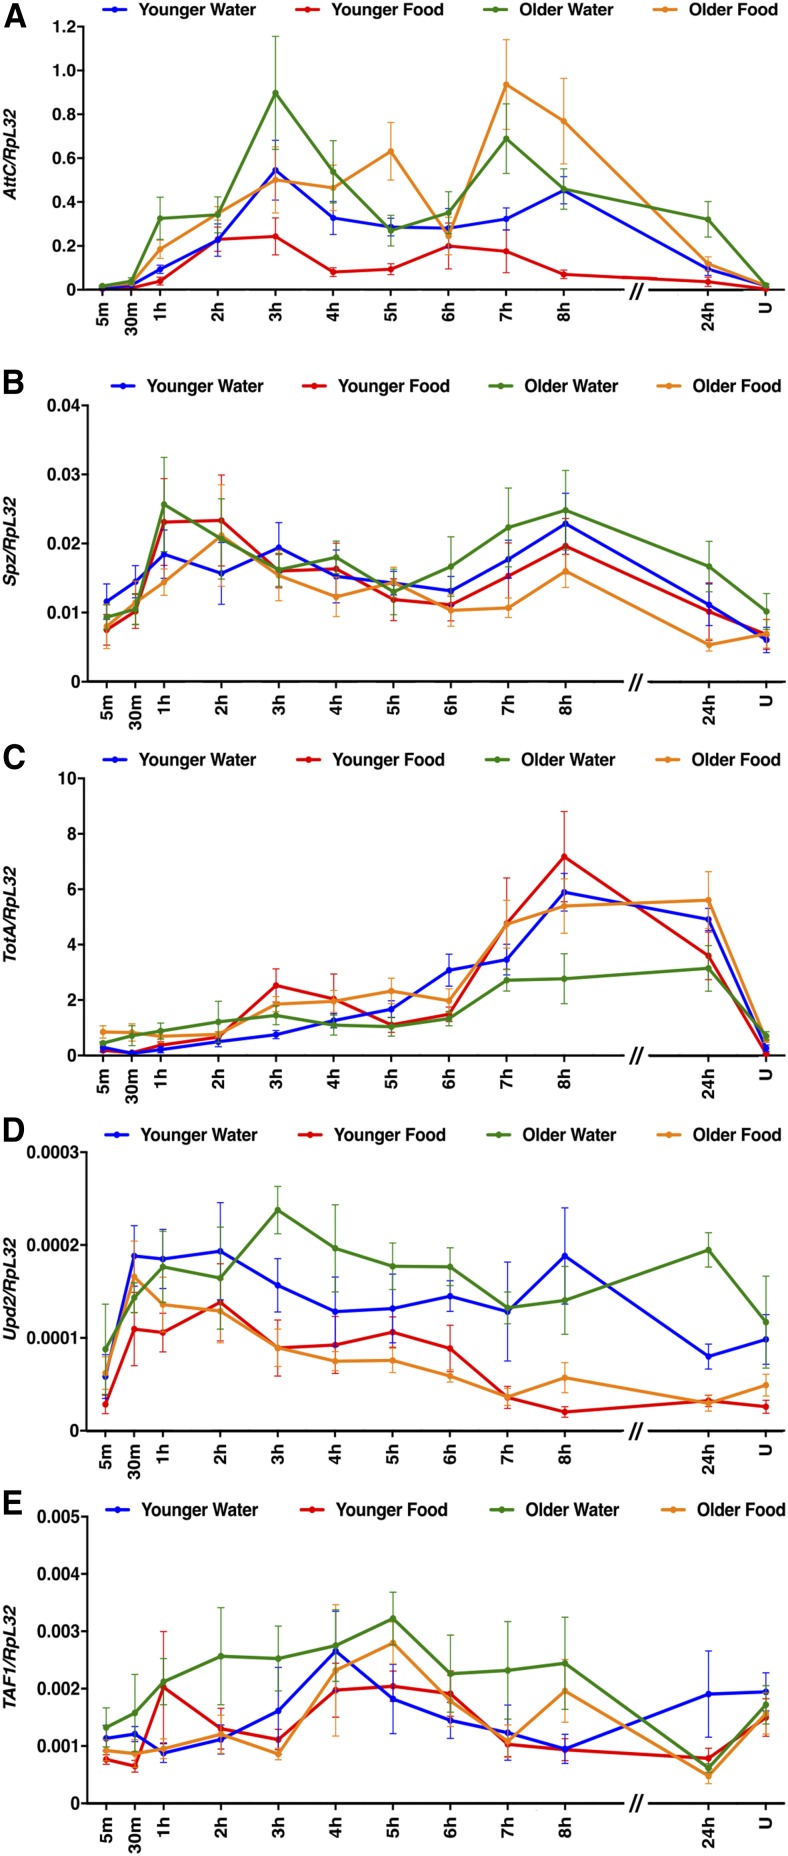
Age and diet affected expression of some innate immune response genes following primary injuries. (A–E) Expression of the indicated genes relative to RpL32 following the standard injury protocol in w1118 flies under the indicated conditions. Note that y-axis scales are different among graphs and that the x-axis is not to scale between 8 and 24 hr. Each data point is the average and SEM of at least three biological replicates. RNA samples used for this analysis were also used in Figure 7, Figure 8, Figure 9, and Figure 10.